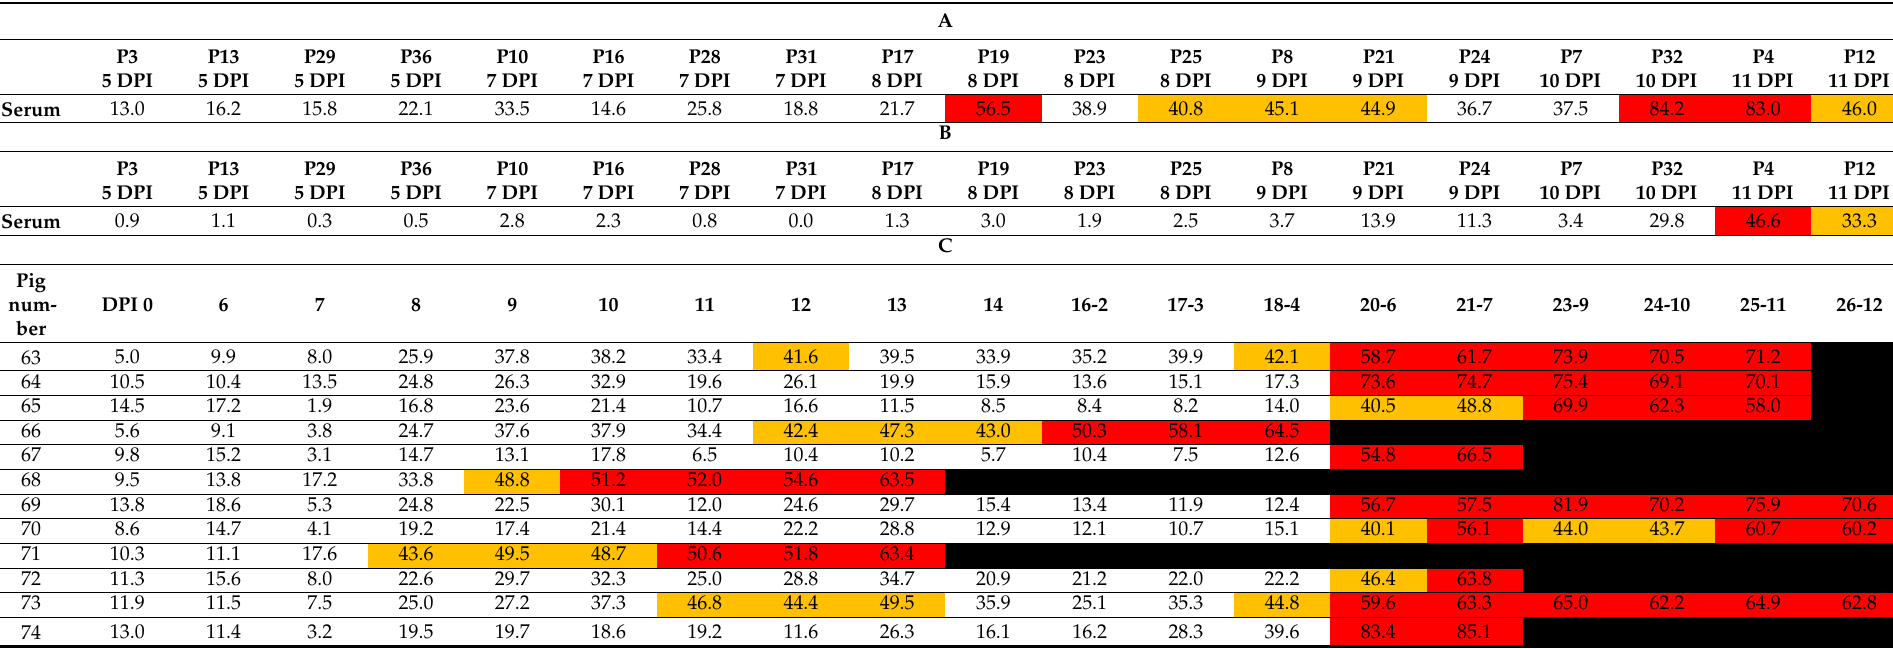
Table 2. Anti-ASFV antibody levels in the serum samples from ASFV Estonia 2014 and ASFV OURT/88/3-infected